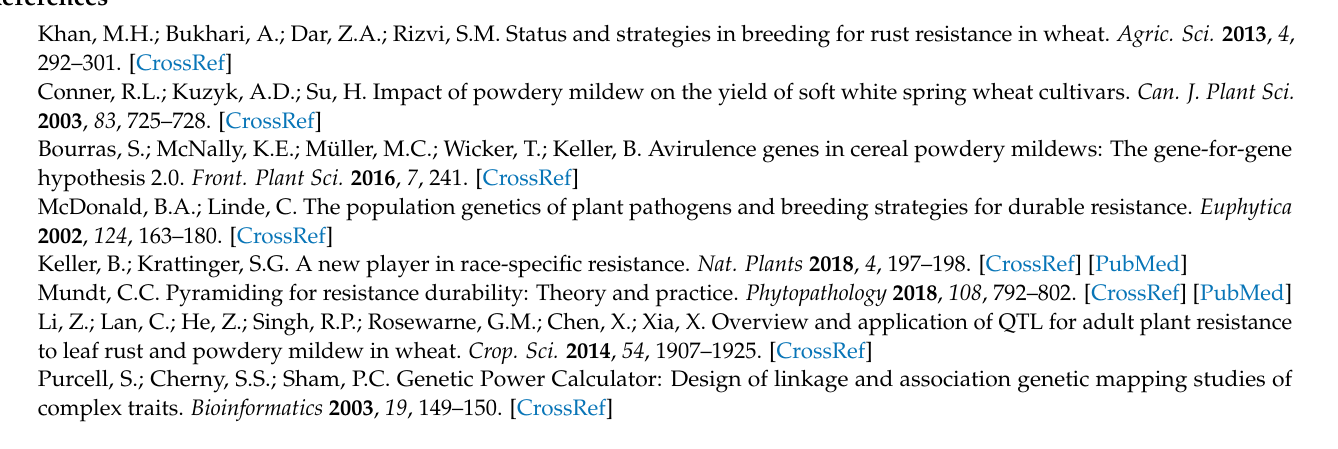
Table S1: Analysis of variance, Table S2: Victo × Spada linkage map, Table S3: Origins of powdery mildew resistance genes previously mapped to the long arm of chromosome 7A, Table S4: Primer pairs developed to amplify the Lr 1 gene, Table S5: BLAST results obtained using the ‘Victo’ and the cloned Lr 1 sequences (GeneBank Acc. N. ABS29034.1) as a query towards the Chinese Spring reference genome, Table S6: Transcriptional profile of candidate genes selected for powdery mildew in response to biotic stresses in leaves and shoots retrieve from the ExpVIP platform, Table S7: Tran- scriptional profile of candidate genes selected for leaf rust in response to biotic stresses in leaves and shoots retrieve from the ExpVIP platform, Supplementary File 1: Nucleotide sequence